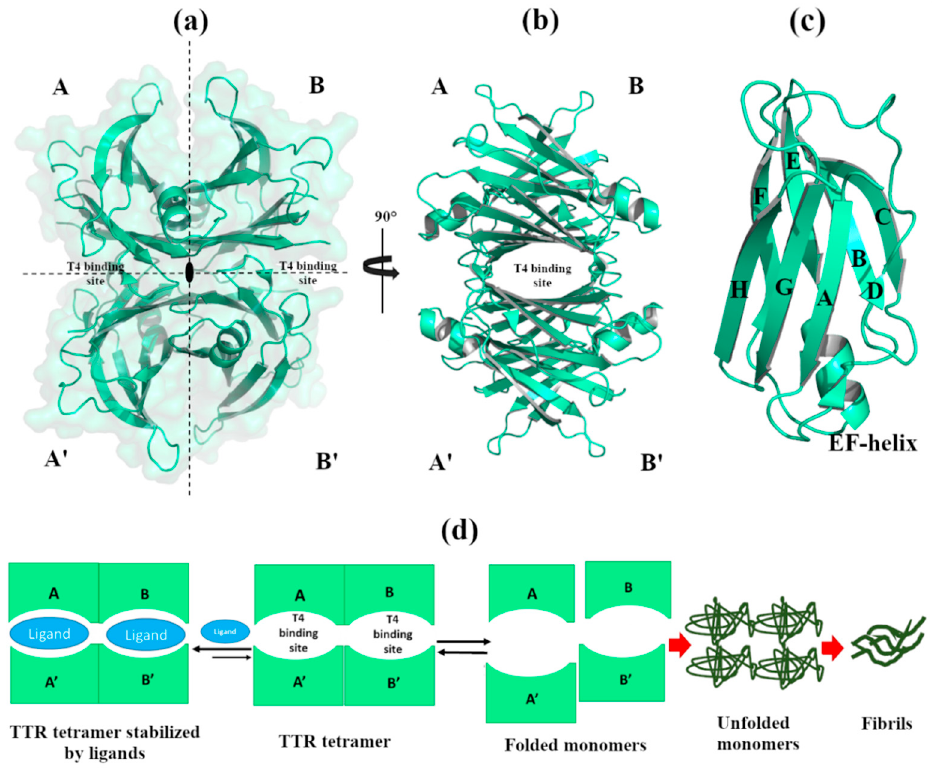
Figure 1. Graphical representation of the human transthyretin (TTR) crystal structure. The figure was created by author using the Protein Data Bank (PDB) id 4TQI [4]). ( a ) The TTR tetramer is composed by monomers A, A’, B, B’ assembled together around the 222-fold axis. The molecular surface is colored in pale green. ( b ) TTR tetramer, rotated of 90°, displays the T4 binding sites that cross the entire tetramer. ( c ) Structural details of monomer A. ( d ) Schematic representation of amyloidogenic pathway.